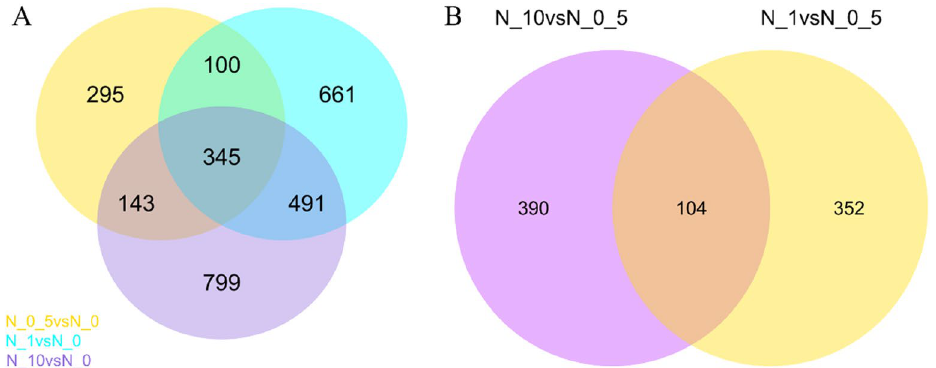
Figure 5. Venn diagram of DEGs. Panel ( A ) represents the DEGs in the three treatment groups compared to treatment N0 as a control. Panel ( B ) represents the DEGs in treatments N1 and N10 compared to treatment N0.5 as a control. The sum of the numbers in each large circle represents the total number of DEGs in the comparison combination, and the overlapping circles represent the number of DEGs in common between the combinations.